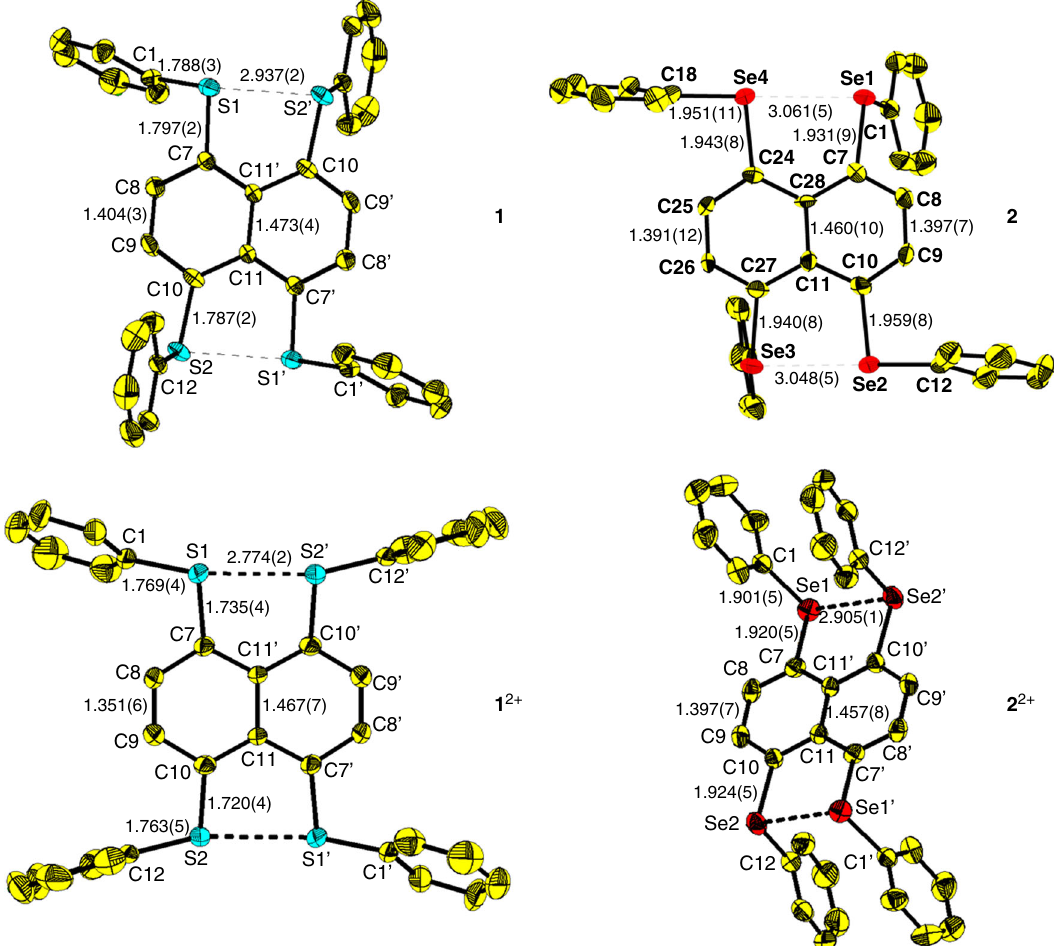
Fig. 3 50% ellipsoid drawings of 1, 1 2 + , 2, and 2 2 + . Yellow, carbon; red, selenium; blue, sulfur. Hydrogen atoms are not shown. Selected bond length (Å) and angle (deg): 1 S1 … S2 ′ 2.937(2), S1 – C1 1.788(3), S1 – C7 1.797(2), C7 – C8 1.375(3), C8 – C9 1.404(3), C9 – C10 1.365(4), C10 – C11 1.438(3), C11 – C11 ′